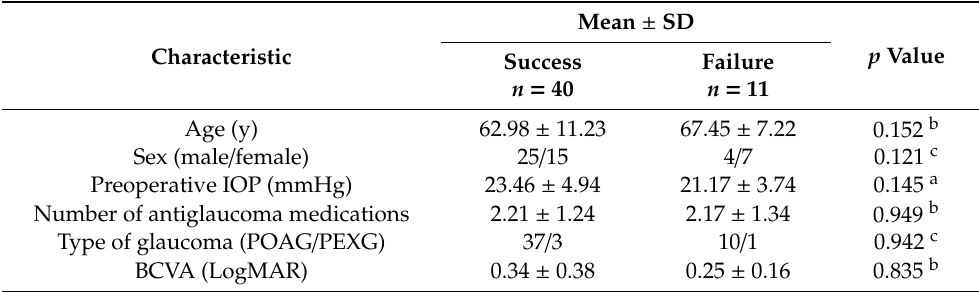
Table 1. Patients characteristics before surgery.